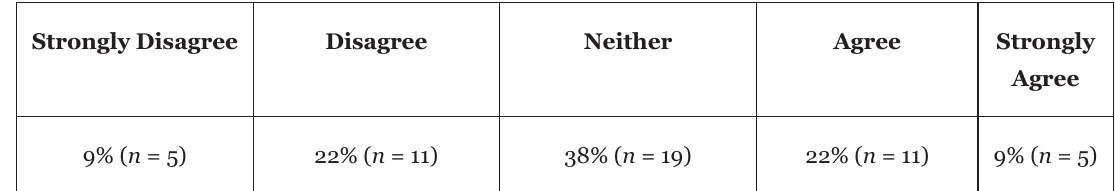
Responses to the Question about Being Well-Informed about How to Transition Courses